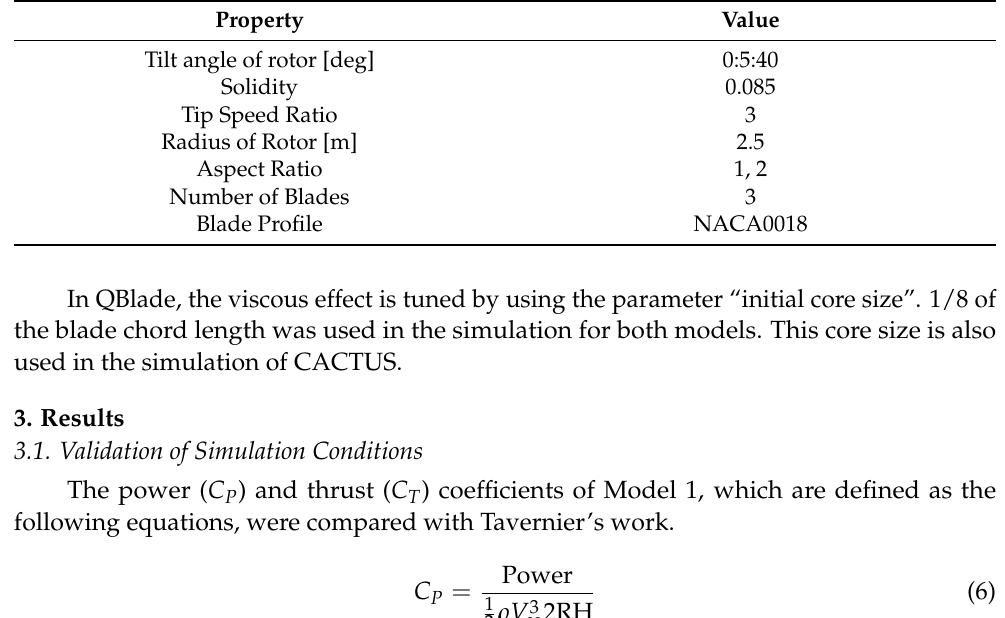
Table 2. Principal particulars of Model 2 (VAWT under tilted conditions).